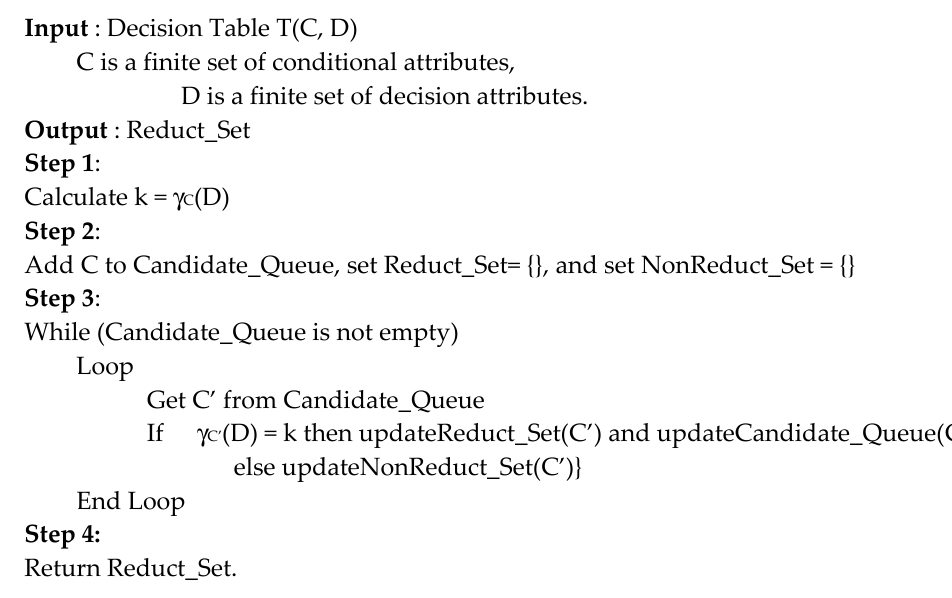
Figure 2. updateReduct_Set(C’) procedure.